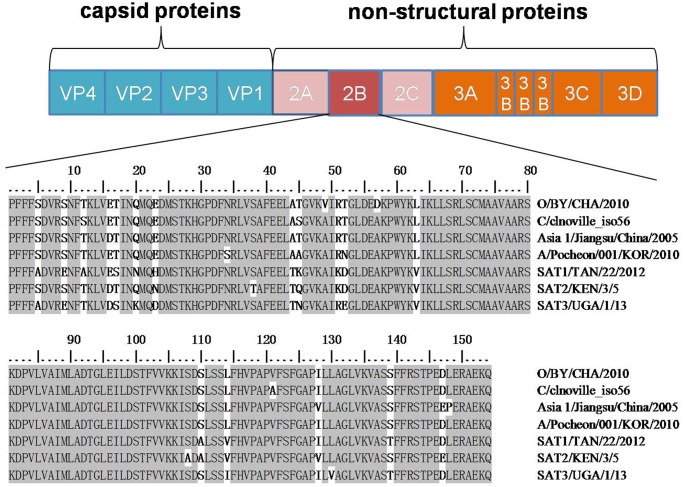
A schematic representation of the FMDV proteins and a multiple alignment of the 2B protein among FMDV serotypes.One isolate of each serotype of the 2B protein sequences was listed in the alignment. The sequences labeled in red represent the two transmembrane domains predicted by the online software.